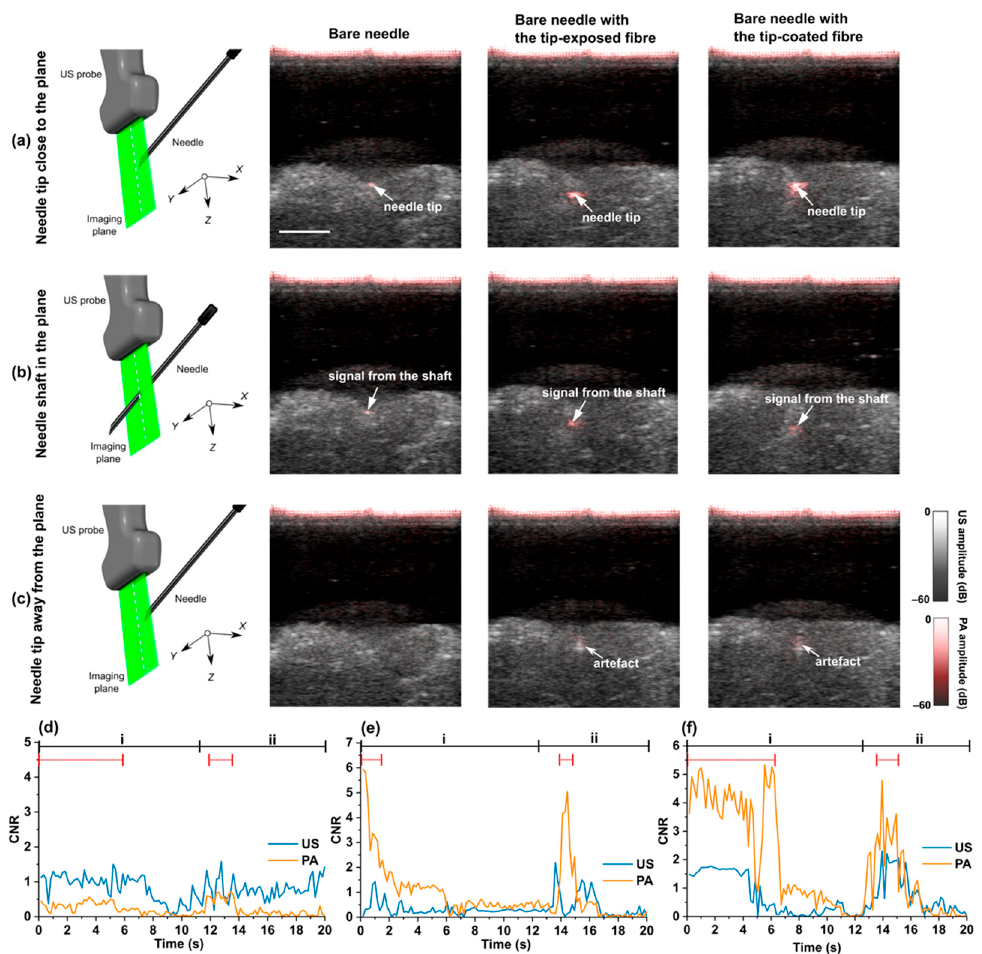
Figure 4. Overlaid photoacoustic (PA) and Ultrasound (US) images of out-of-plane insertions into pork joint ex-vivo using a bare needle, a bare needle with a tip-exposed fibre, and a bare needle with a tip-coated fibre. ( a – c ) schematic illustrations of the needle tip location during out-of-plane needle insertions: ( a ) needle tip close to the imaging plane, ( b ) needle shaft in the imaging plane, and (c) needle tip away from the imaging plane. ( d – f ) show the contrast-to-noise ratios (CNRs) of the needle in PA and US images during a 20 s out-of-plane procedure; i: needle was inserted towards the imaging plane; ii: needle was withdrawn from the imaging plane; time intervals covered by the red dotted lines correspond to the needle tip in the imaging plane (approximately 0–6.1 s and 12.2–13.7 s in ( d ); 0–1.8 s and 13.6–14.9 s in ( e ); 0–6.5 s and 13.3–15.7 s in ( f )); Images were obtained from real-time reconstruction and displayed on a logarithmic scale. All the images have the same scale bar of 1 cm.